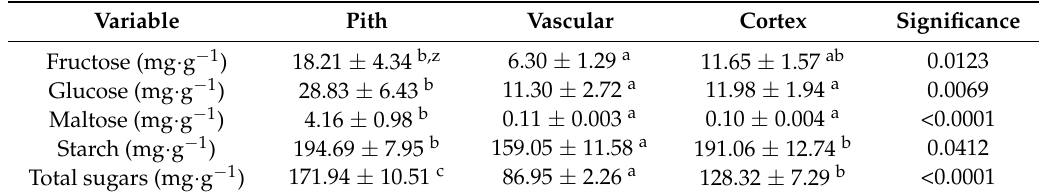
Table 1. The influence of radial position within Cycas micronesica stems on non-structural carbohydrates. Means are a combination of apical and basal stem